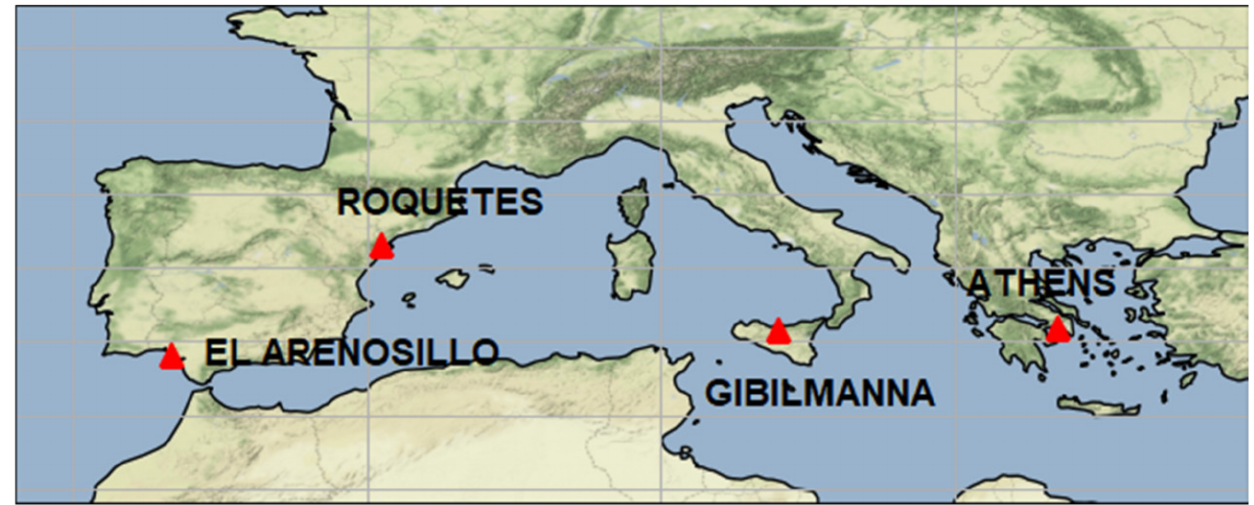
Figure 2. Map with the distribution of digital ionosondes used in this work: El Arenosillo (37.1 N, 6.7 W), Roquetes (40.8 N, 0.5 E), Gibilmanna (37.9 N, 14.0 E) and Athens (38.0 N, 23.5